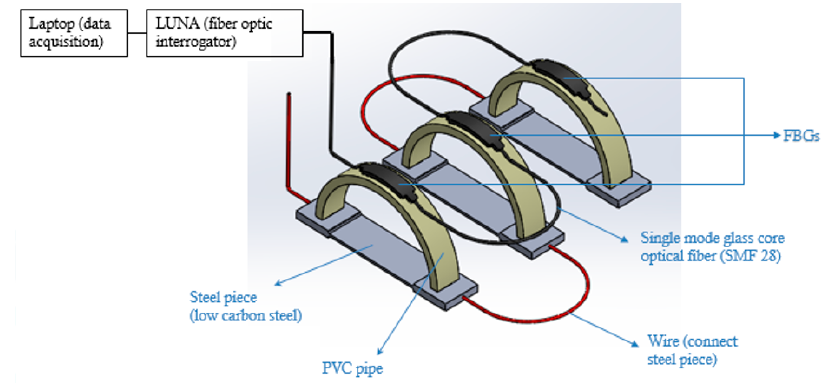
Figure 12. Schematic of details of proposed sensor.